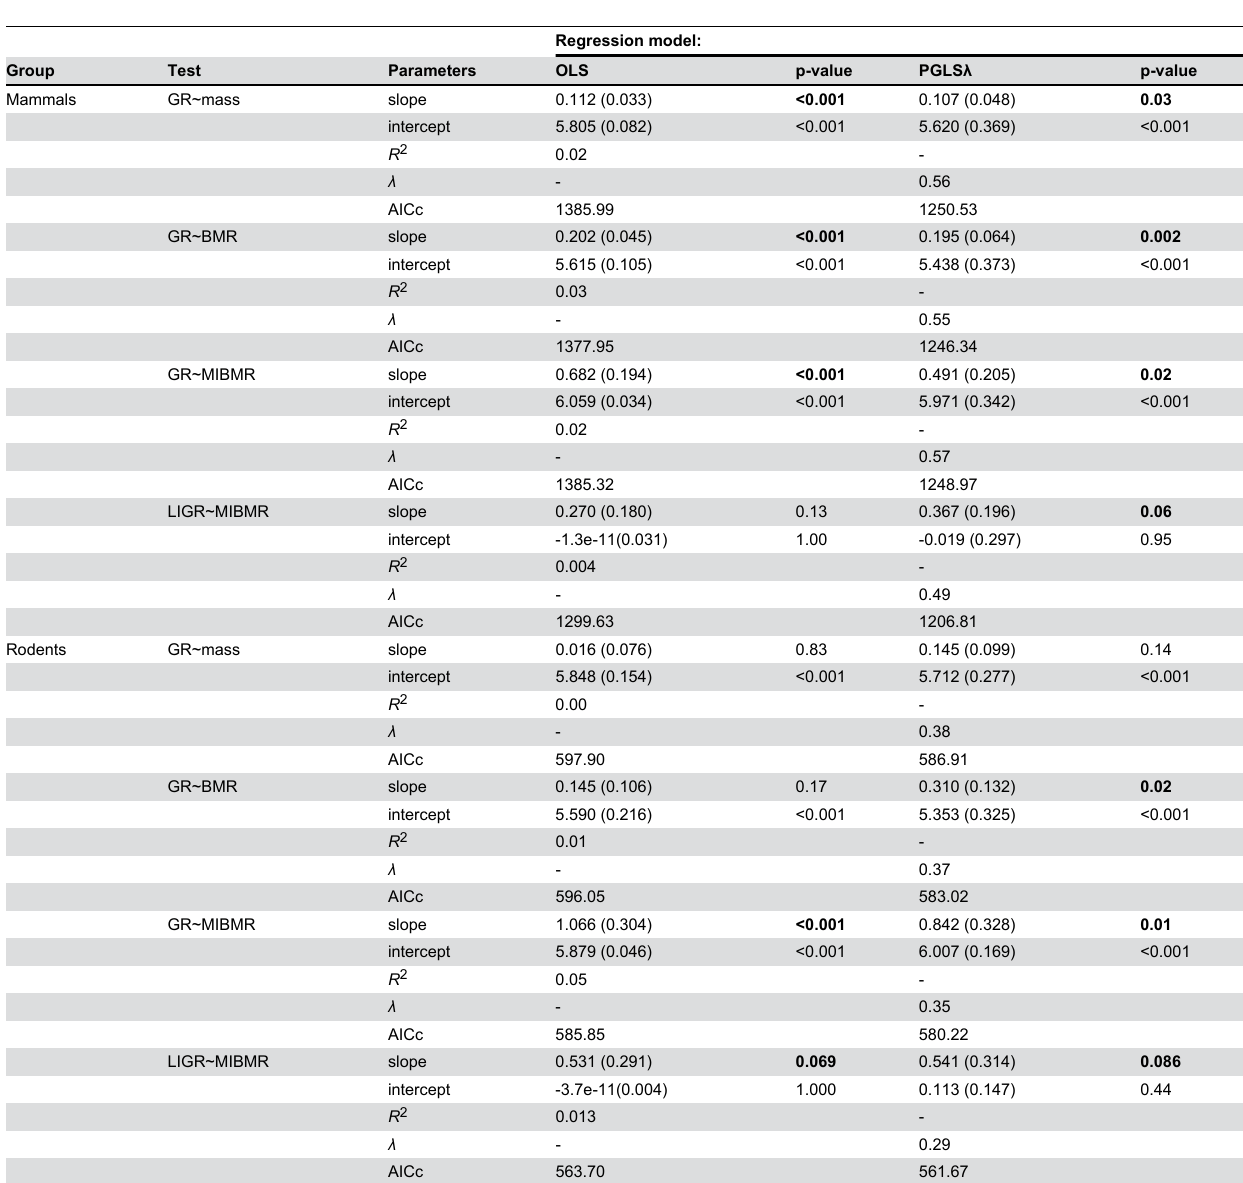
Table 2. Global non-phylogenetic (OLS) and phylogenetic (PGLSλ) simple linear regressions of geographic range size versus mass, BMR, and MIBMR in all mammals and